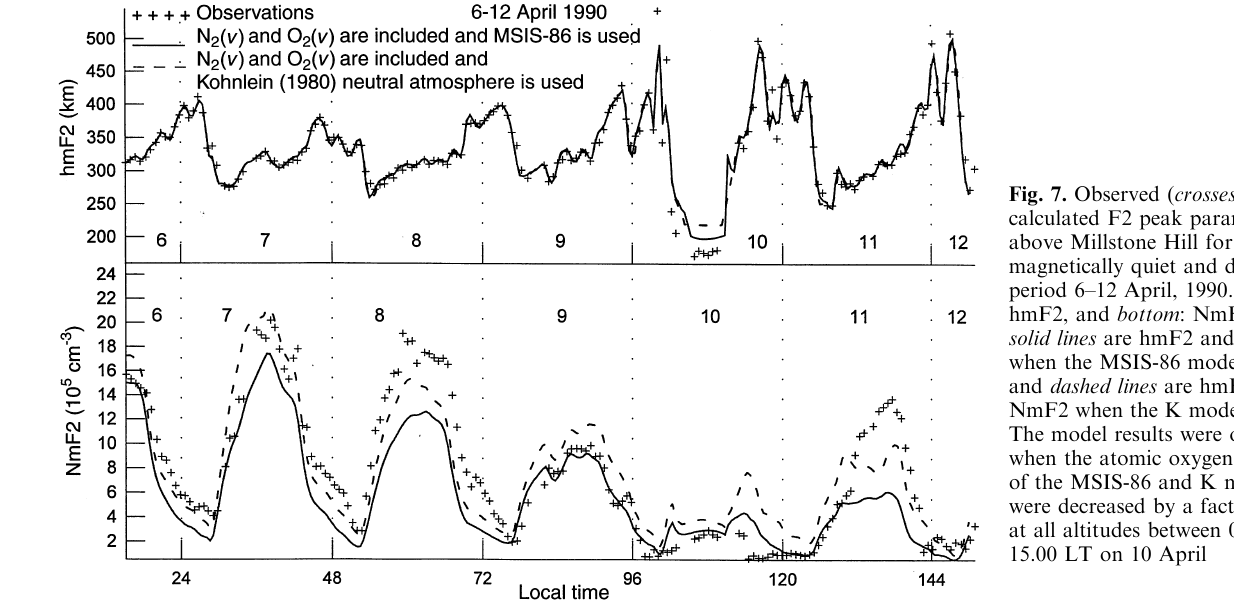
Fig. 7. Observed ( crosses ) and calculated F2 peak parameters above Millstone Hill for the magnetically quiet and disturbed period 6–12 April, 1990. Top : hmF2, and bottom : NmF2. The solid lines are hmF2 and NmF2 when the MSIS-86 model is used, and dashed lines are hmF2 and NmF2 when the K model is used. The model results were obtained when the atomic oxygen densities of the MSIS-86 and K models were decreased by a factor of 1.8 at all altitudes between 07.00 and 15.00 LT on 10